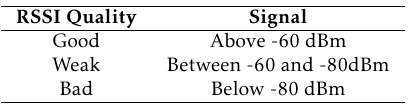
Table 1. Statistics for different network environments